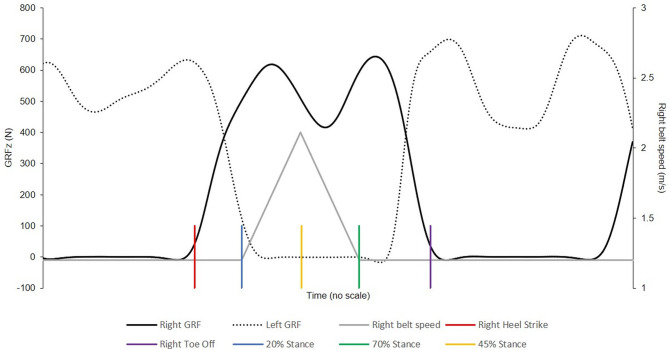
Slip timing representation; the right belt (belt speed represented as the grey line) starts accelerating at 20% of the right leg stance phase and is back to normal (1.2 m·s−1) at 70% of the right leg stance phase. GRFz, vertical ground reaction force.